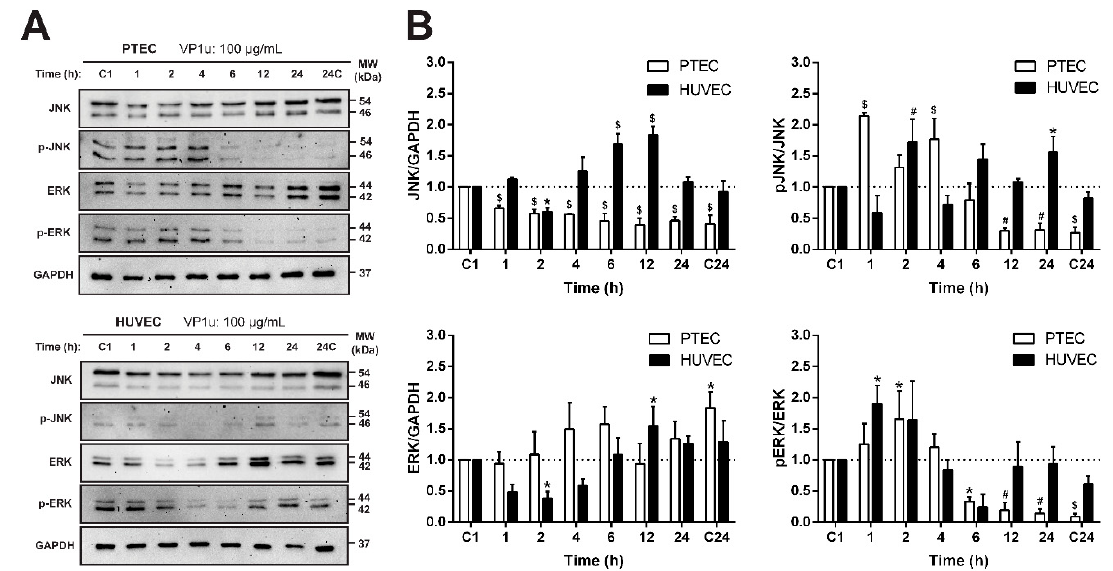
Figure 5. VP1u’s effect on the mitogen activated protein kinases (MAPK) levels and phosphorylation in EC. ( A ) Expression profiles of JNK and ERK proteins after exposing EC to 100 µg/mL of VP1u. ( B ) Quantification of the total and phosphorylated proteins at different times of VP1u exposure. The results are presented as mean ± SD. p ≤ 0.05 (*), p ≤ 0.01 (#), p ≤ 0.001 ($) vs. the control (C1).